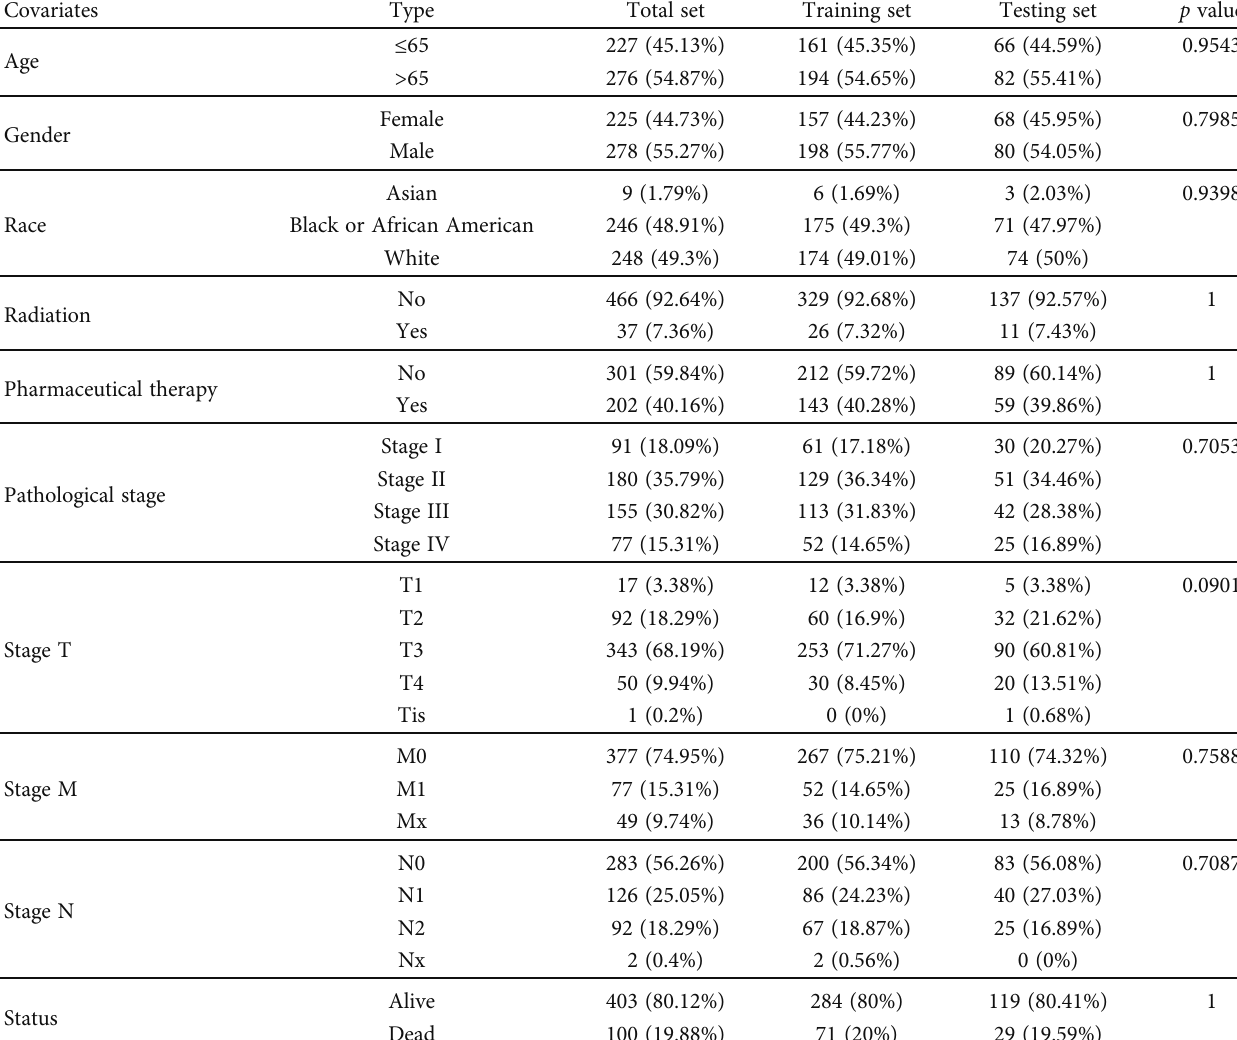
Table 1: The clinical characteristics of the di ff erent